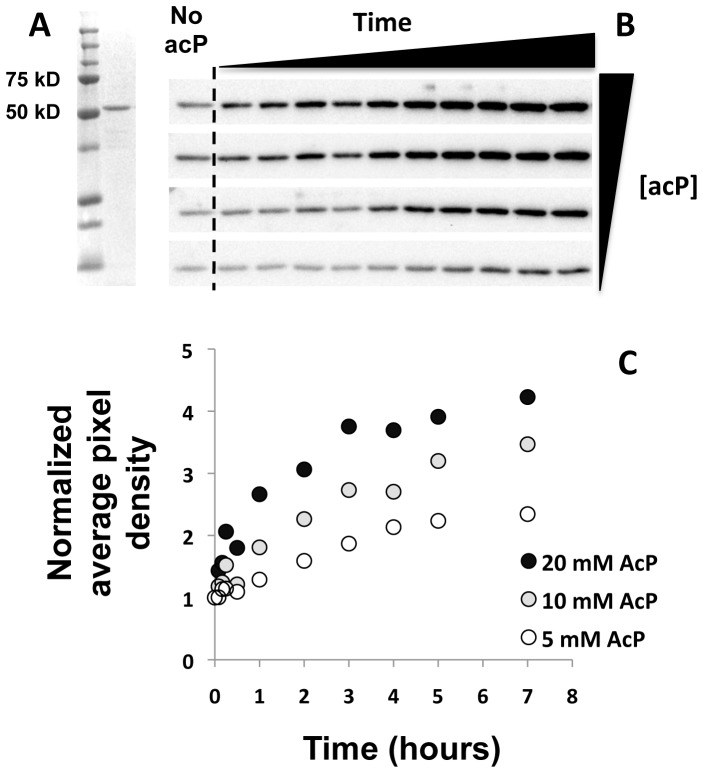

In vitro acetylation of LpdA using acP as the acetyl group donor is sensitive to acP concentration and time of incubation.Coomassie stain of SDS-polyacrylamide gel and anti-acetyllysine Western immunoblot analysis of acP (5, 10, 15, 20 mM) incubated with 1.25 µM LpdA for various lengths of time (5, 10, 15, and 30 min, 1, 2, 3, 4, 5, and 7 hours) at 37°C. Acetylation signals were quantified using AlphaView and normalized to the signal in the absence of acP.